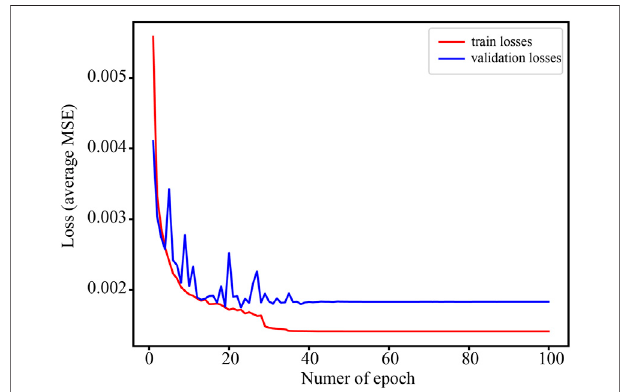
FIGURE 2 | Training loss and validation loss curves.